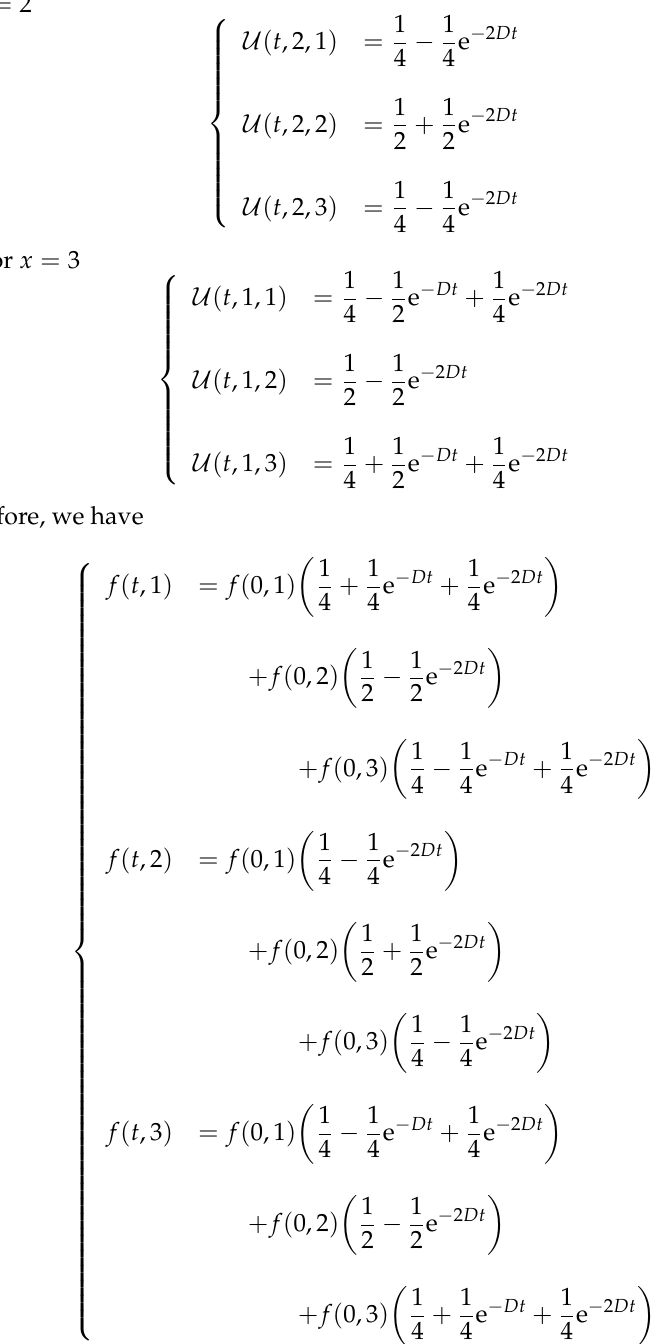
Figure 4 plots the evolution of the three